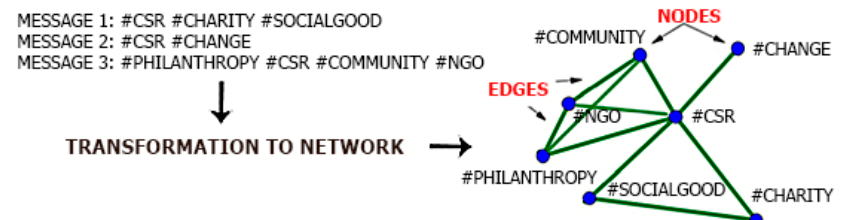
Figure 2. Transformation example of hashtags from messages to the network (case study of corporate social responsibility). Source: reference [14].